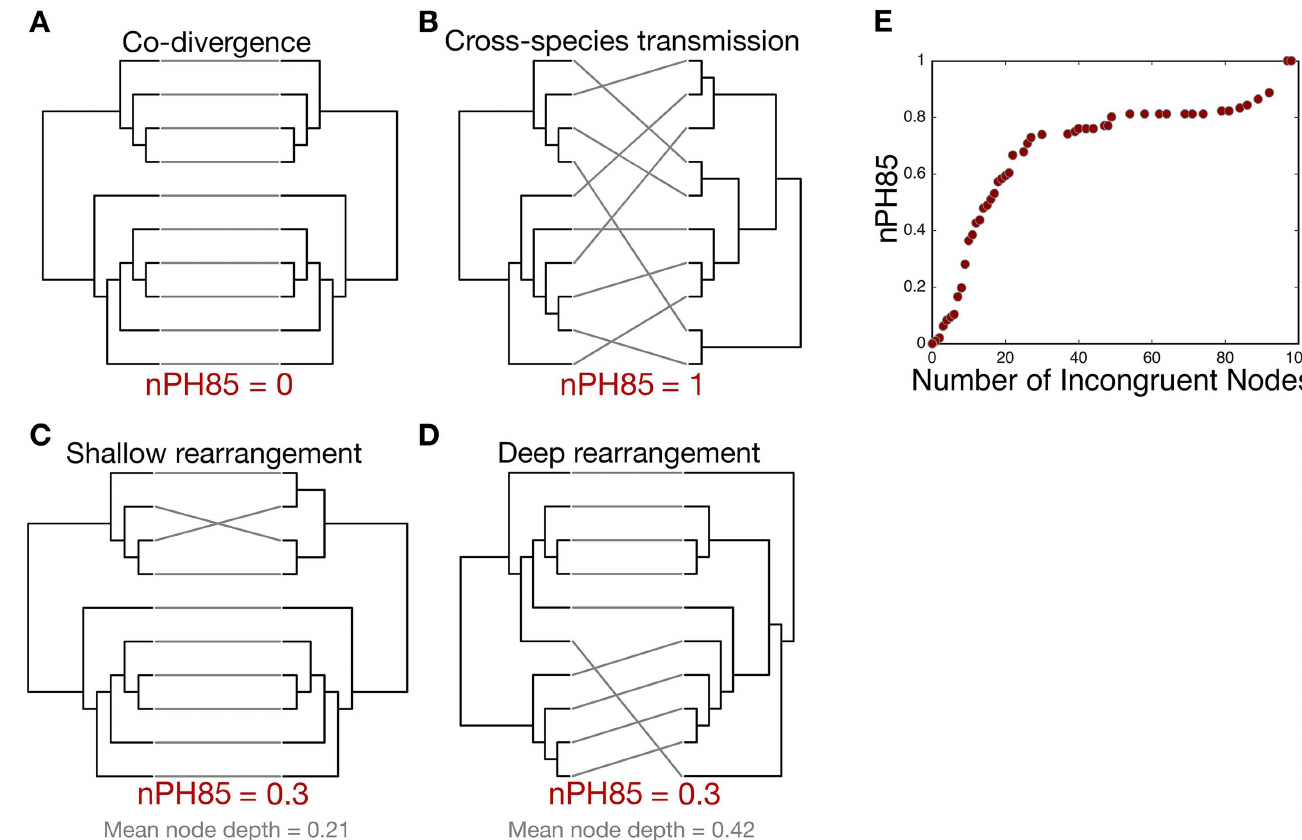
Fig 1. Tanglegrams of phylogenetic trees created using simulated data. Lines connect the virus with its respectivehost. Hence, if viruses and hosts have congruent phylogenies—indicativeof strong virus-host co-divergence—then there will obviouslybe more horizontal than diagonallines. Panel (A) illustrates a perfectly matched topologybetweenvirus and host trees and thus the nPH85= 0. Panel (B) exemplifies an entirely mismatched topology betweenvirus and host trees, where the nPH85 = 1. Data from viruses in nature will fall betweenthese two extremes. Panels(C) and (D) illustrate two exampleswhere the host trees have one incongruent node. Panel (C) corresponds to a shallowersection of the tree than in panel (D), but the two nPH85 are the same, such that the position of the incongruencedoes not producea systematic bias. Panel (E) elucidatesthe relationship betweenthe nPH85 distanceand the number of incongruent nodes betweena pair of simulatedtrees with 100 tips.